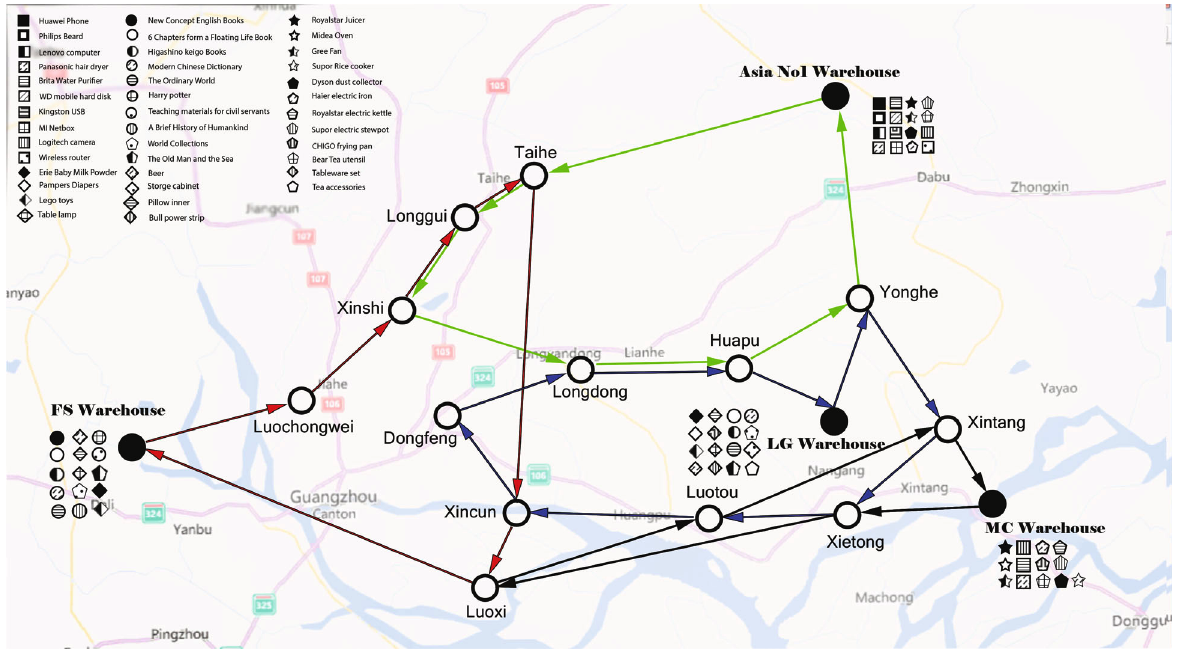
Figure 11: Vehicle routes for real-world instance Case1. Table 4: Impact of the main VNS